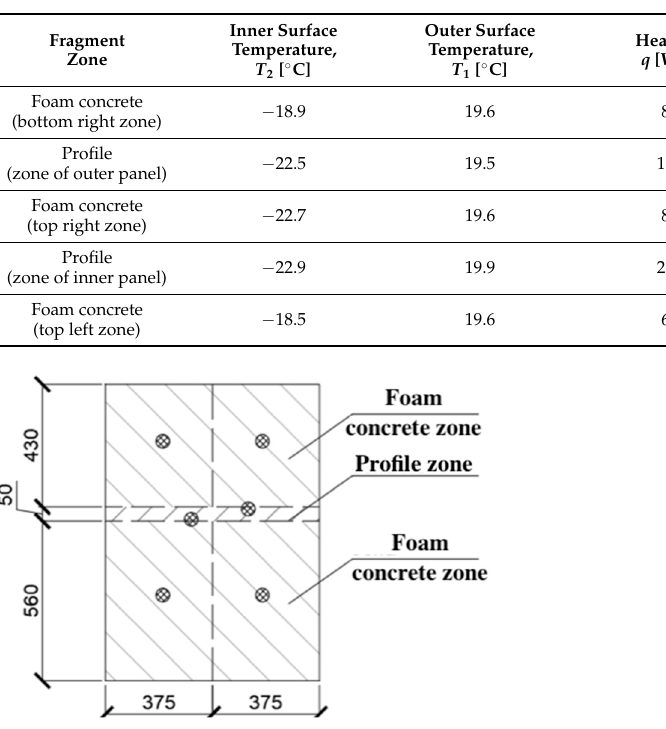
Table 1. Fragment of a monolithic wall with a thermoprofile inside.